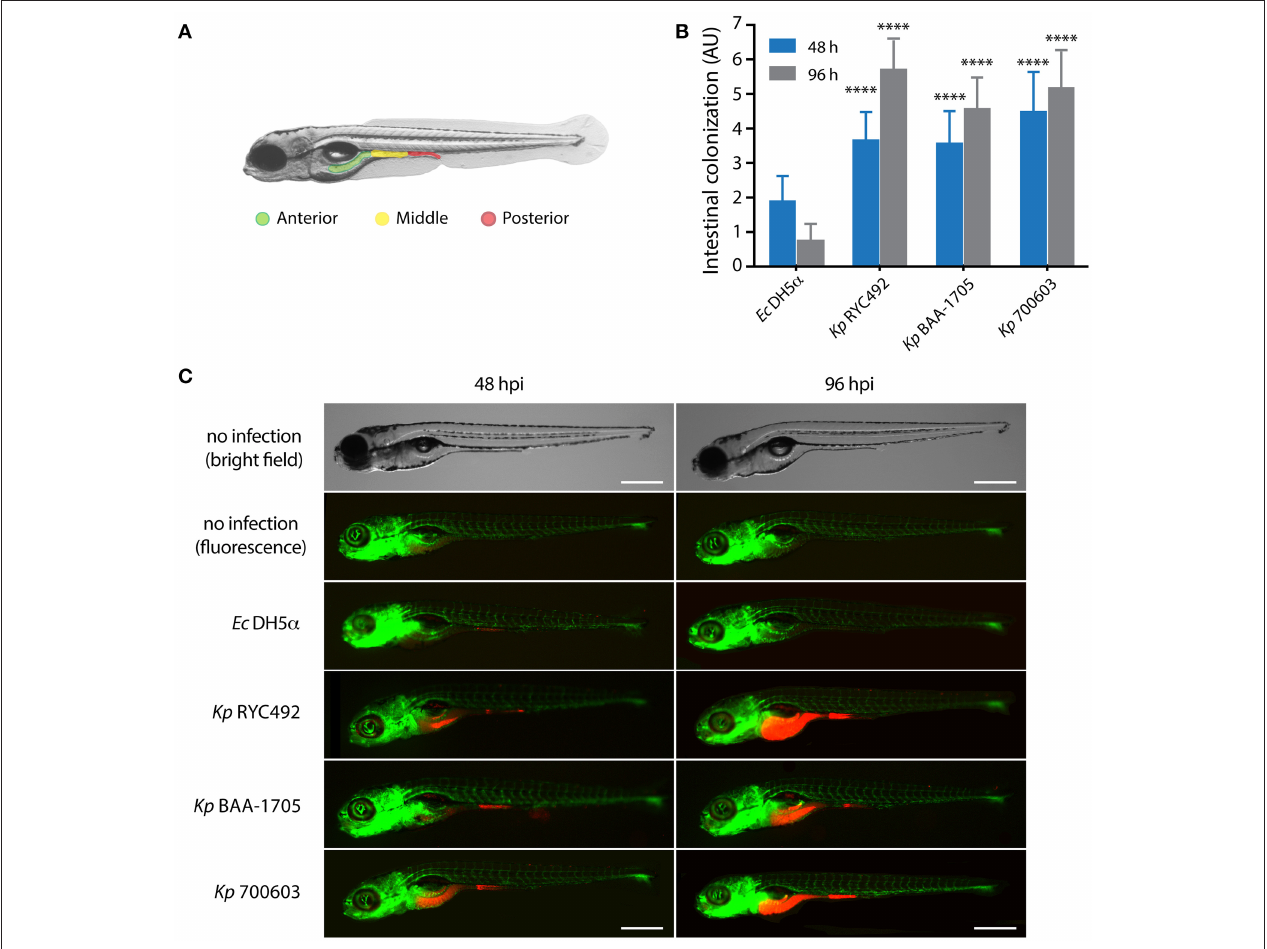
FIGURE 5 | K. pneumoniae can infect zebrafish larvae by immersion and colonize its gastrointestinal tract. (A) Scheme of the gastrointestinal tract of a 5-dpf zebrafish larva, showing three arbitrarily defined zones (anterior, middle and posterior). (B) Semi-quantitative assessment of the intestinal colonization upon immersing zebrafish larvae in a suspension containing different K. pneumoniae strains or with E. coli DH5 α . At the indicated time, larvae were anesthetized, observed under a fluorescence stereomicroscope, and the total intestinal colonization was scored in a scale from 1 to 9, following the criteria described in the Materials and Methods section. The data presented correspond to six replicates with a total of 75 larvae per bacterial strain. (C) Fluorescence microphotographs of zebrafish larvae representative of the data showed in (B) . Bright field images of representative non-infected larvae at 48 and 96h post-immersion are presented for more clarity. The larvae vasculature is shown in green, while infecting bacteria are shown in red. Scale bar, 500 µ m. **** p <